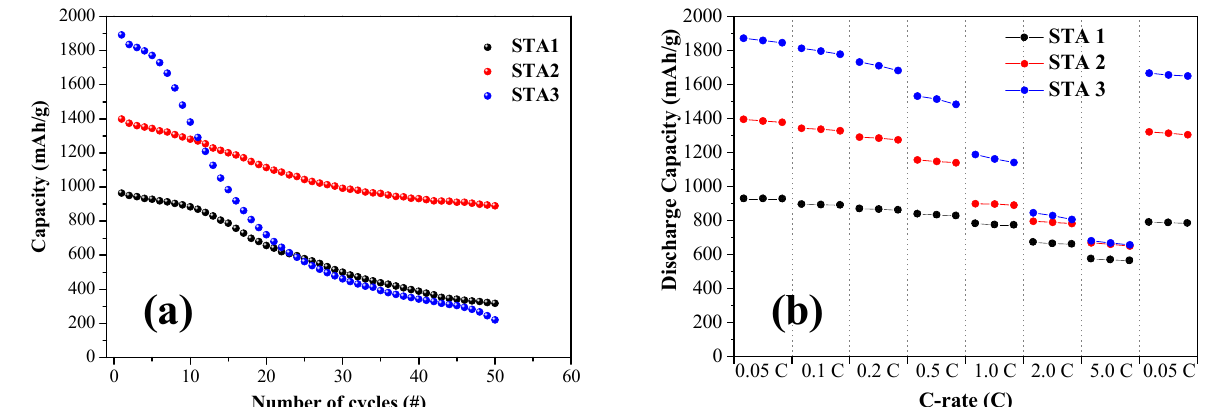
Figure 5. ( a ) Discharge capacity vs. cycle and ( b ) rate capability of STA1, STA2, and STA3.